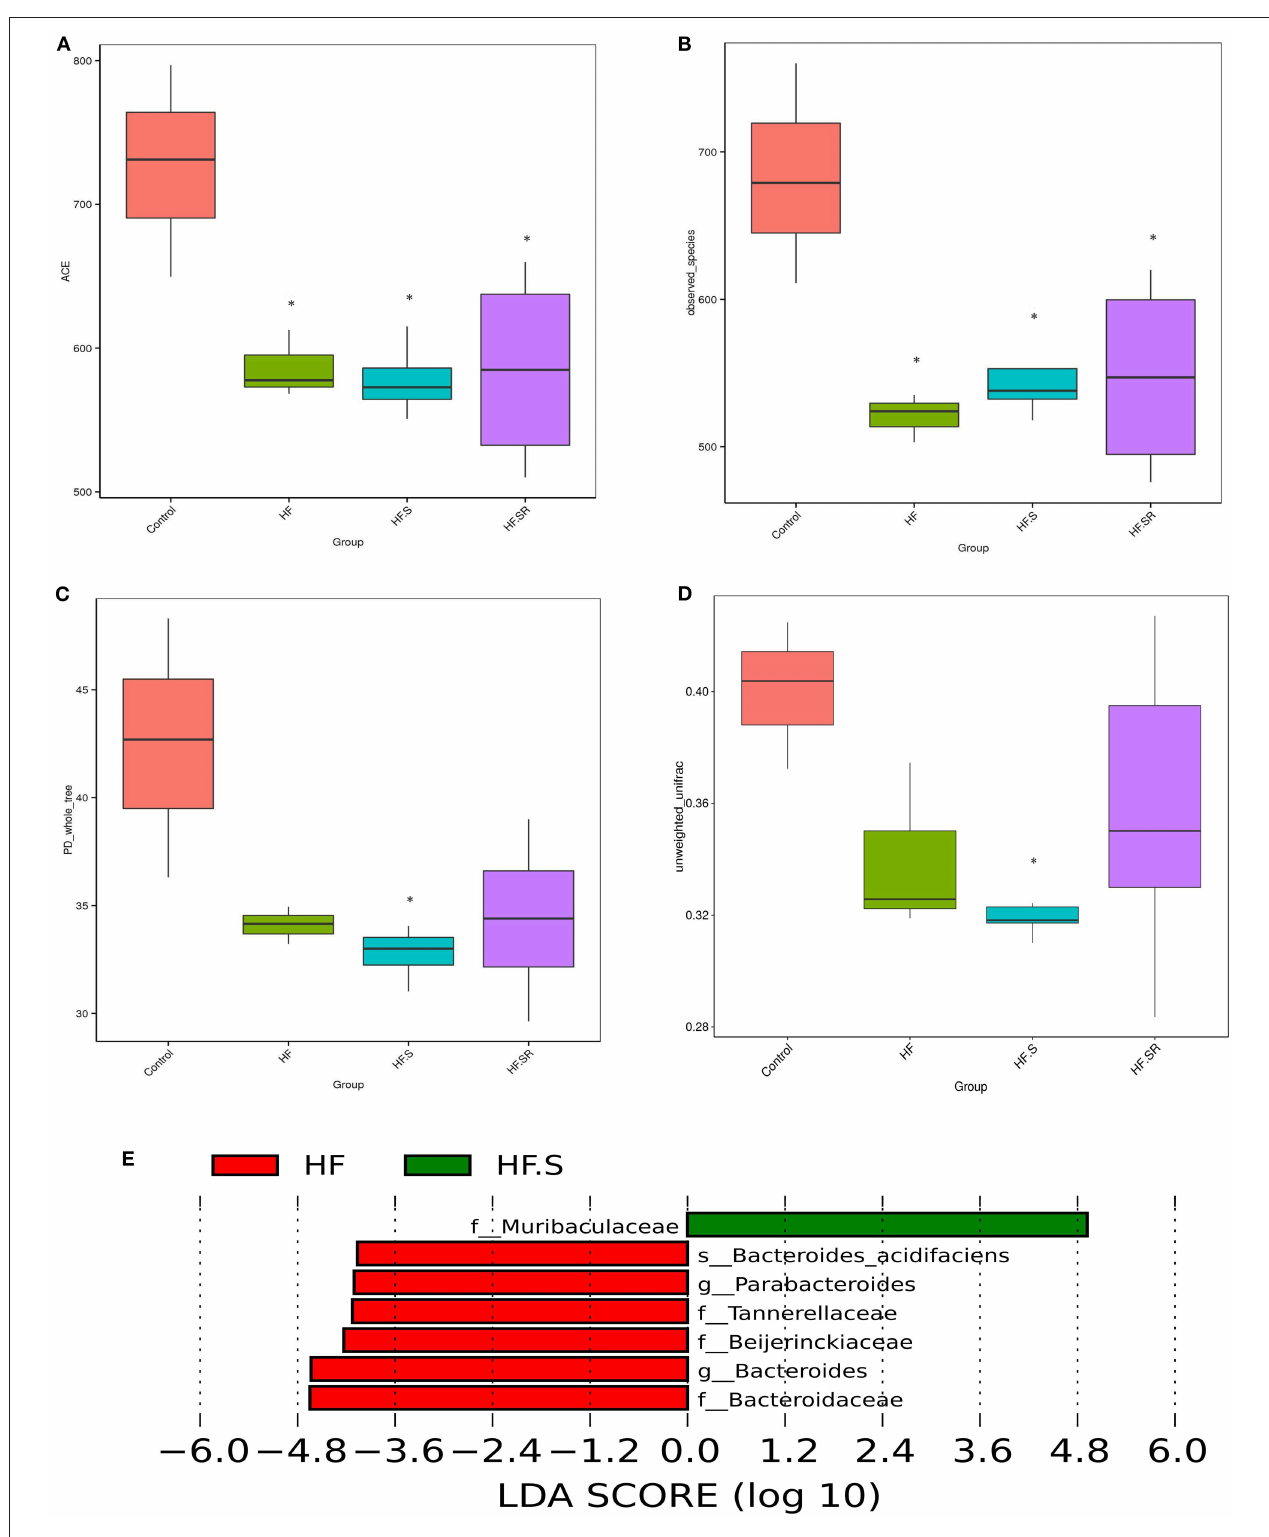
FIGURE 7 | The compositions of the microbial community richness or diversity in the different groups. The community richness was estimated by ACE (A) and the observed-species (B) . The community diversity is represented by the PD-whole tree (C) . Unweighted UniFrac distances revealed significant differences between the controls ( n = 4) and HF + S mice ( n = 8) (D) . The relative abundance of 6 taxa decreased, while only one increased in the HF + S mice compared with the HF mice ( n = 5) (E) . * P < 0.05 vs. controls.